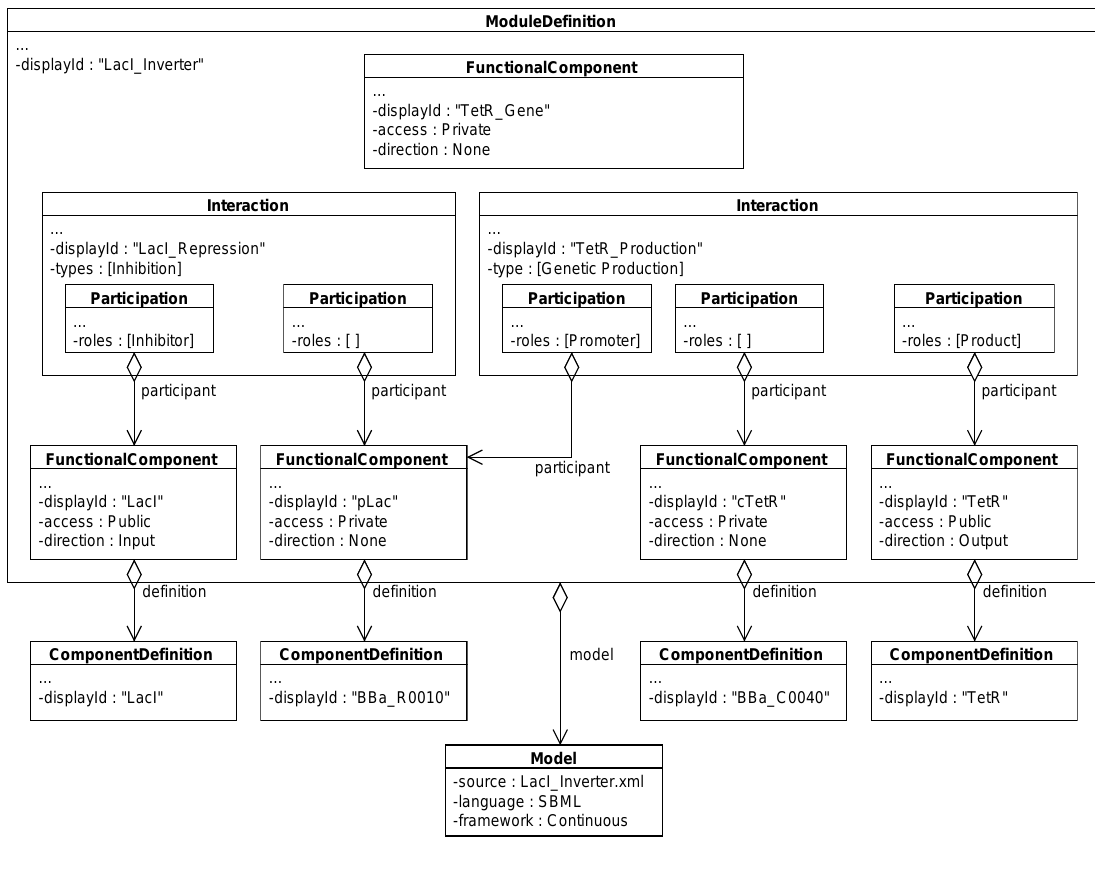
Figure 27: ModuleDefinition of the LacI inverter. This ModuleDefinition contains FunctionalComponent ob- jects that instantiate the ComponentDefinition objects for the LacI/TetR transcription factors and TetR gene. The FunctionalComponent for the TetR gene as a whole does not participate in any Interaction and merely indicates that the function of the gene is described by the LacI inverter ModuleDefinition . The remaining FunctionalComponent objects participate in a repression Interaction and a genetic production Interaction , thereby indicating which biologi- cal structures carry out the function of the LacI inverter ModuleDefinition . In this case, the transcription and translation of TetR are represented as a single genetic production Interaction that abstracts away the presence of the intermediate TetR mRNA. In addition, this ModuleDefinition is also associated with a continuous Model written in the SBML source file